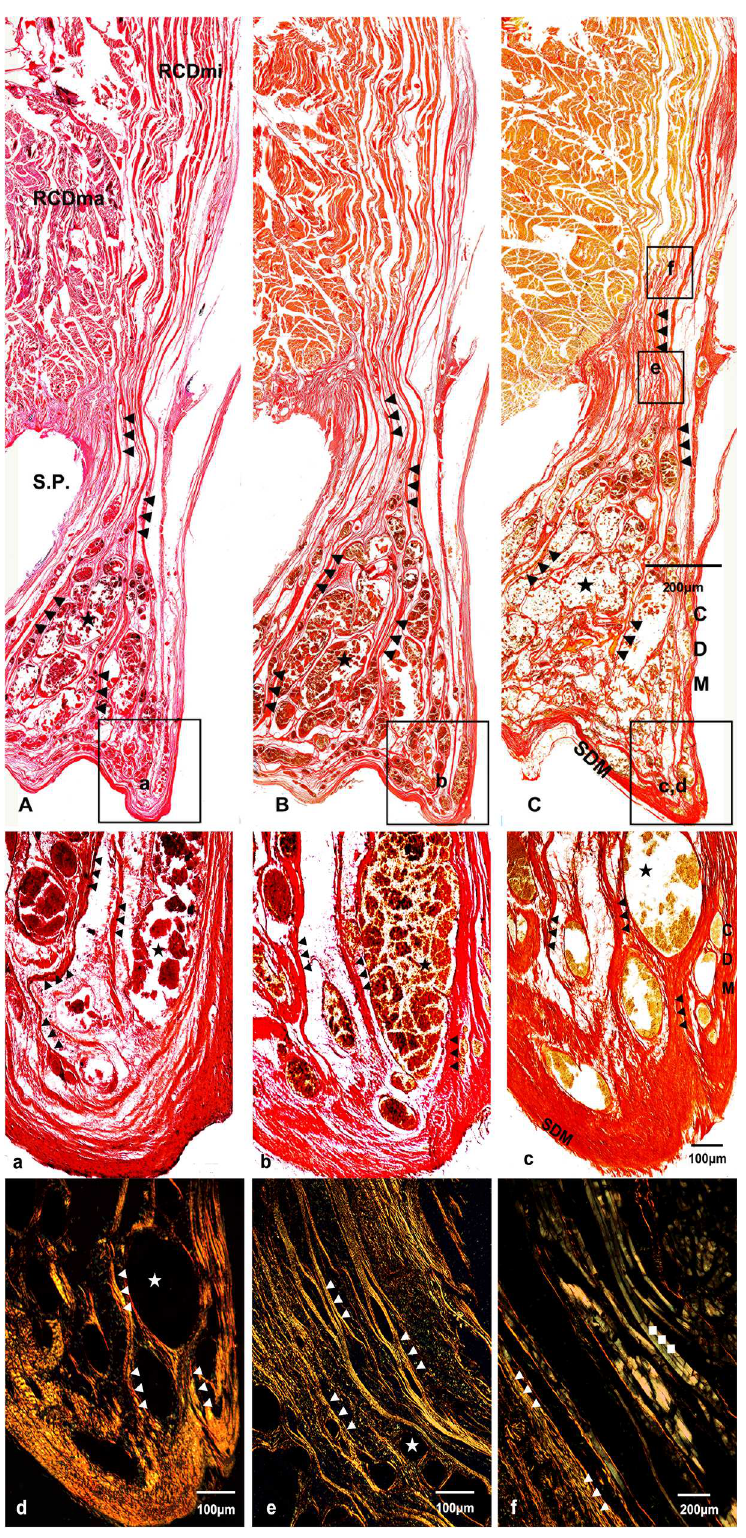
Fig 4. Sagittal sectional histological sheet of suboccipital region of the Neophocaena phocaenoides . A, a: results of Hematoxylin and eosin staining. B, b: results of VG (picric acid and acid fuchsin) staining.C,